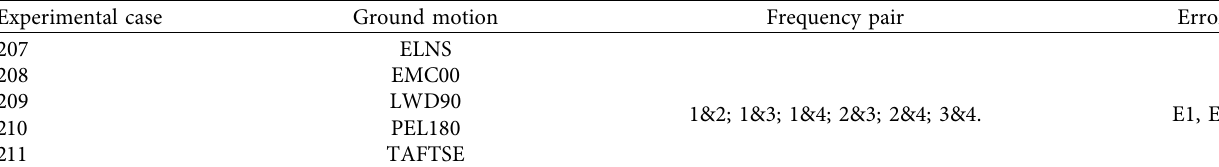
Table 5: Calculation schedule of PGA � 0.07g.